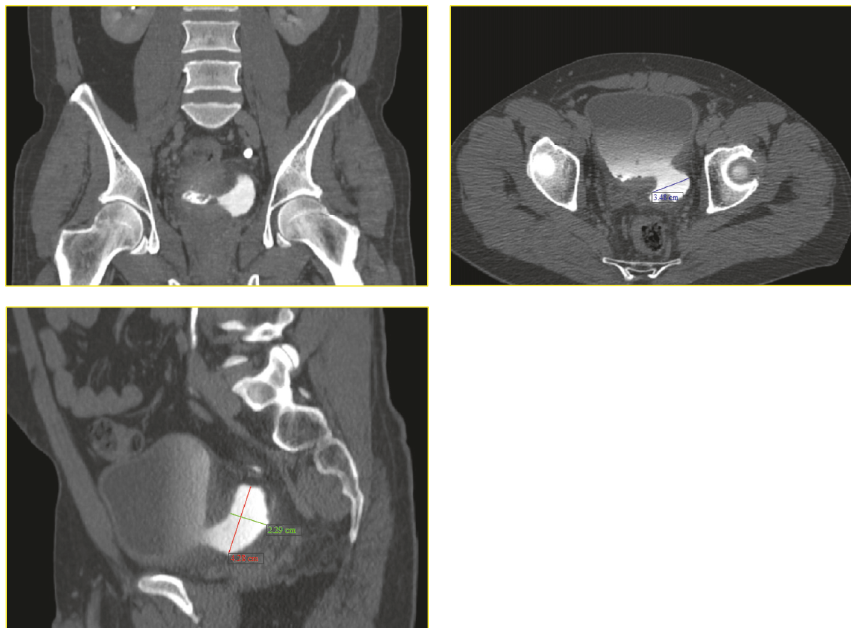
Figure 1: Coronal, sagittal, and axial cuts of bladder diverticulum on computed tomography.